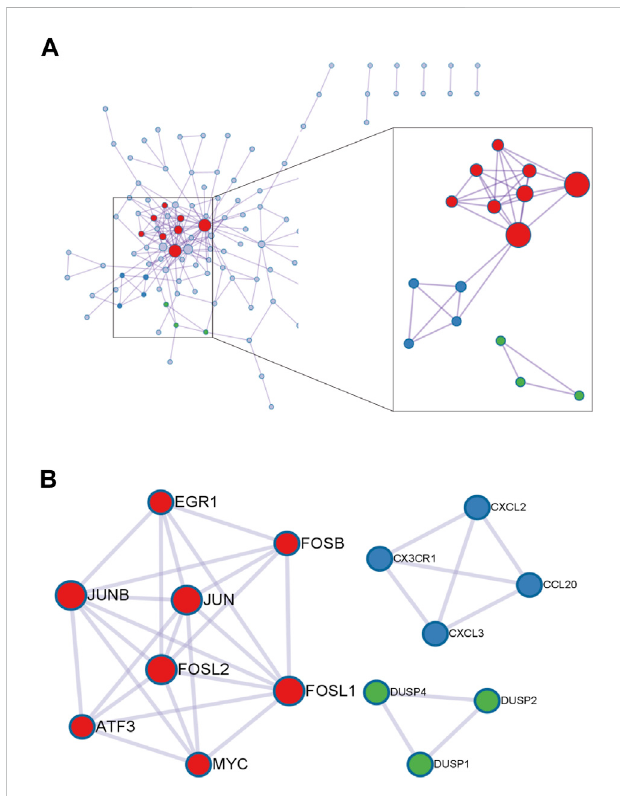
FIGURE 4 PPI analysis of 161 DEGs and screening of key modules. (A) OverviewofthePPInetwork of161DEGsthroughmetascape.Thelarger size of the points, the higher degree of the genes. (B) Genes in three key modules with the highest MCODE value.